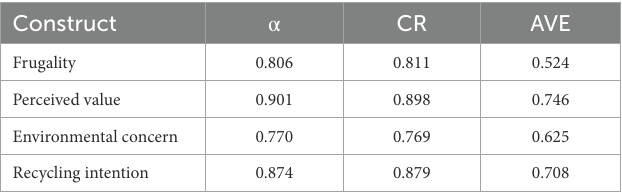
Table 4 presented the results of hierarchical regression. Model 1